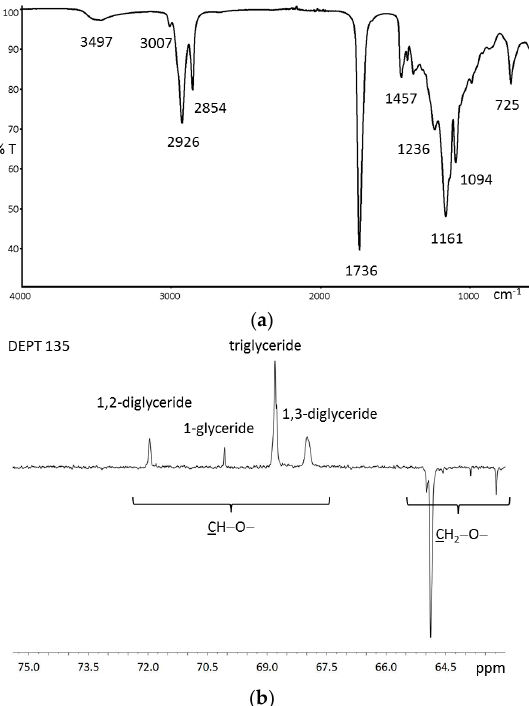
Figure 1. Spectroscopic analysis of the UBP obtained from a feed composition of glycerol, azelaic acid, and TOFA with a molar ratio of 1:1:0.57 (UBP3). ( a ) FT-IR spectrum; ( b ) Expanded DEPT135 NMR spectrum